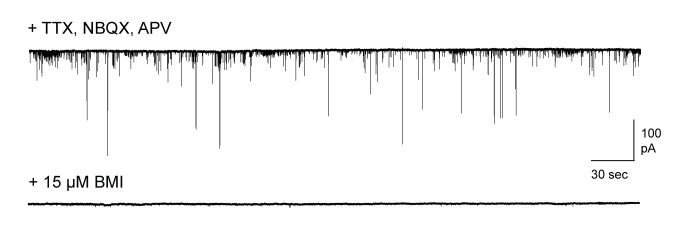
Pharmacologically isolated inhibitory synaptic currents in MCs.Top, inward currents recorded from voltage-clamped MCs using high-chloride pipette solution, measured in the presence of TTX, NBQX, and APV. Bottom, miniature currents were completely blocked by addition of 15 µM bicuculline.